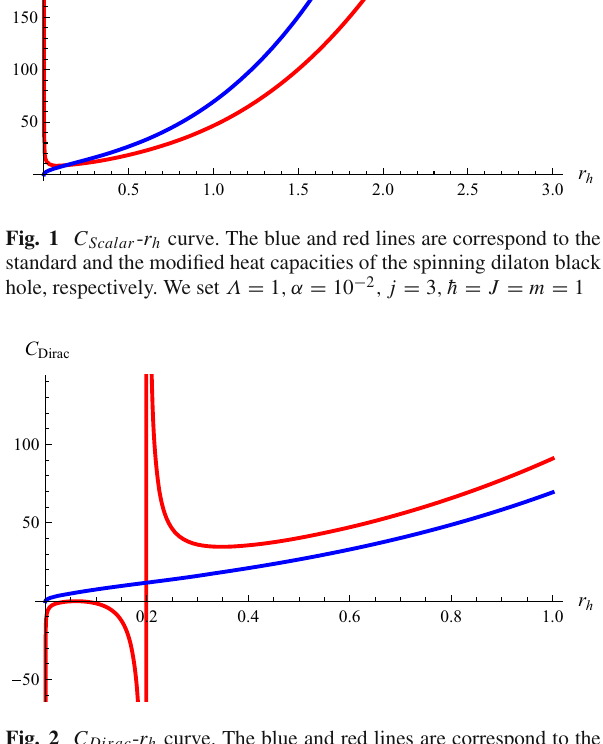
Fig. 2 C Dirac - r h curve. The blue and red lines are correspond to the standard and the modified heat capacities of the spinning dilaton black hole, respectively. We set Λ = 1 ,α = 10 − 2 , j = 3 , ¯ h = J = m = 1